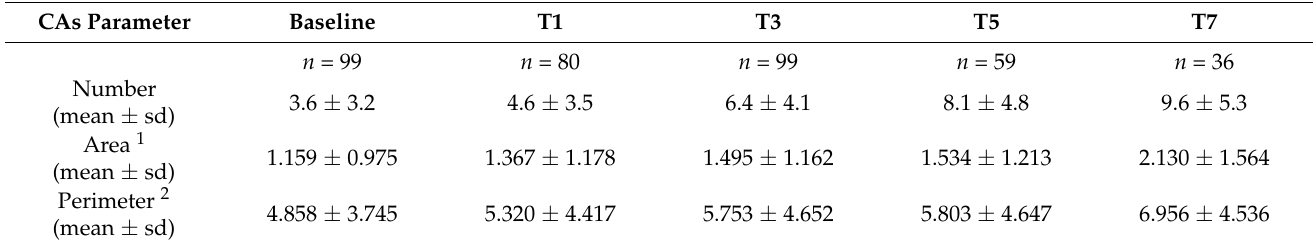
Table 1. Evolution along time of CAs number and